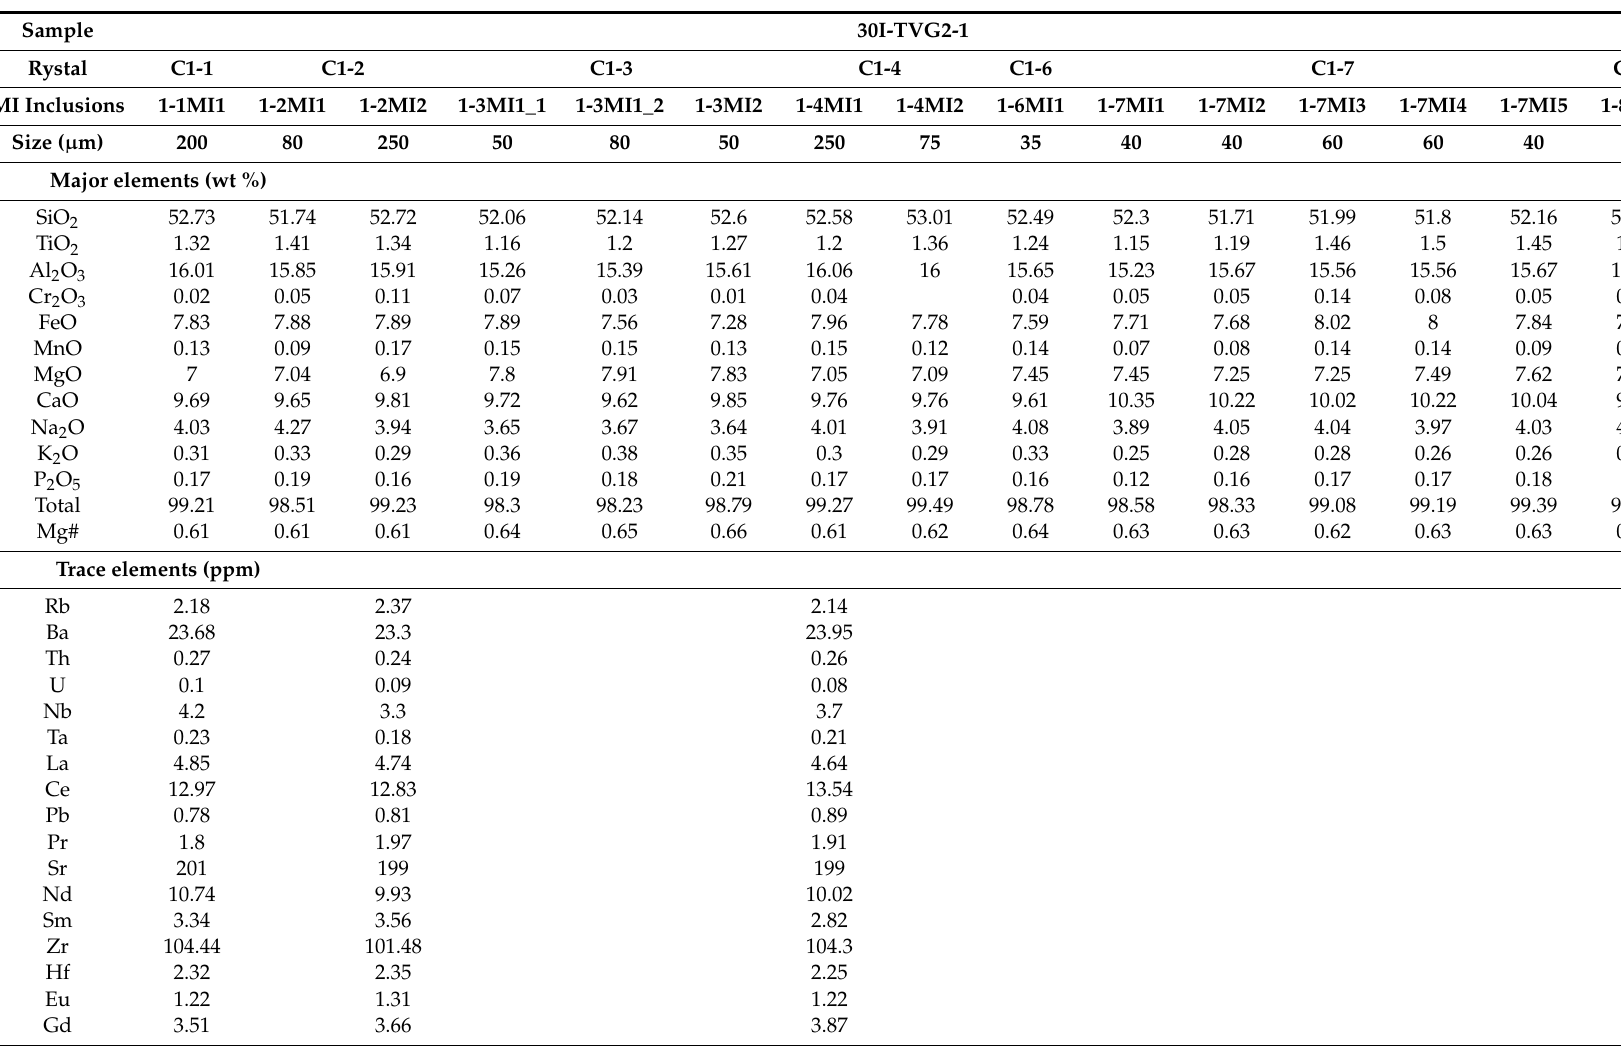
Table 2. Major and trace element concentrations for plagioclase-hosted melt inclusions in Mount Jourdanne